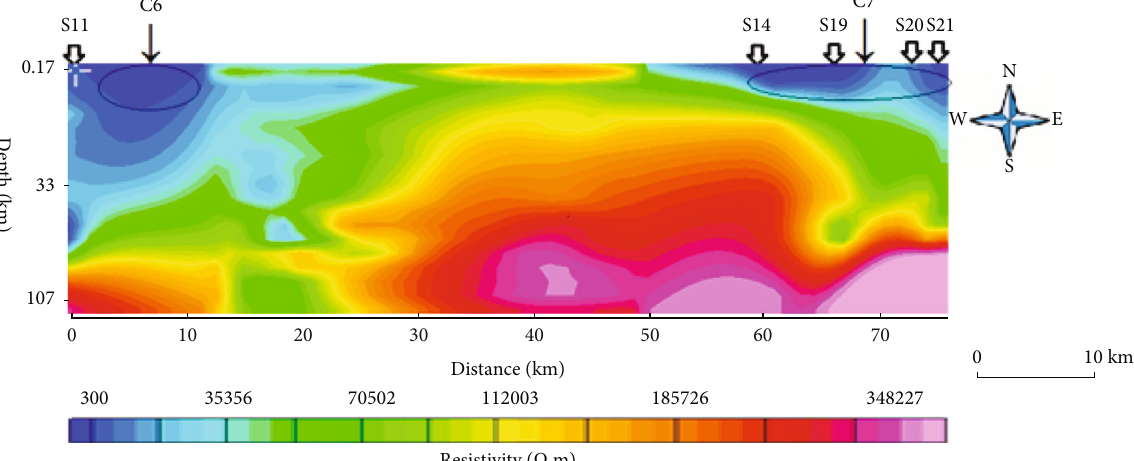
Figure 7: 2D resistivity section of pro fi le P3.